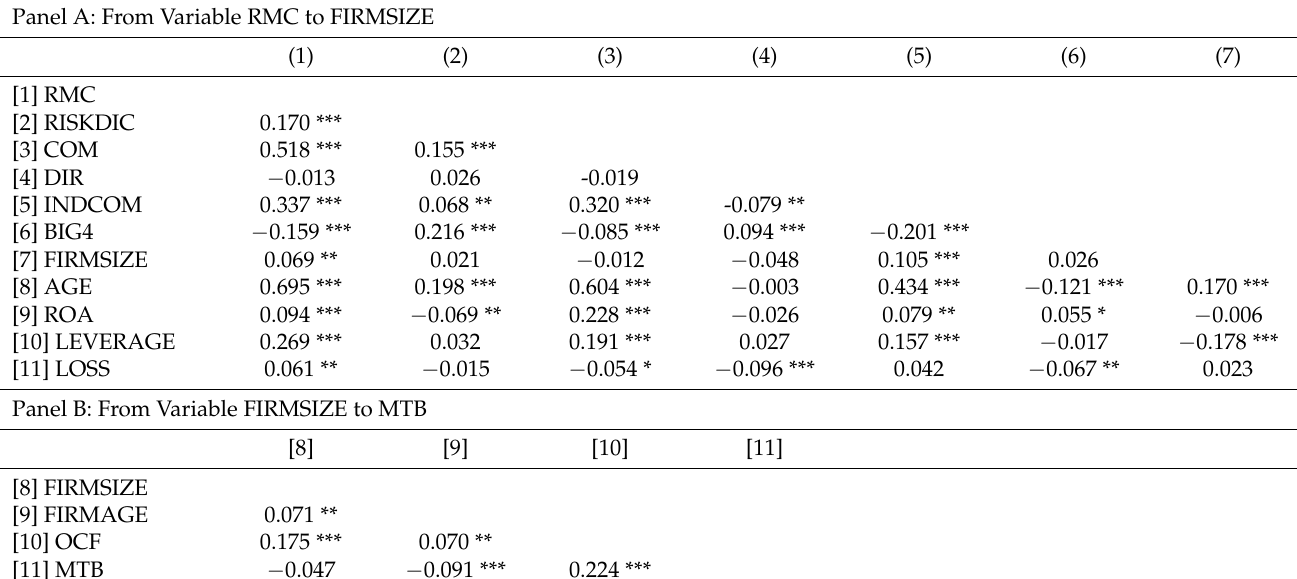
Table 4. Pearson